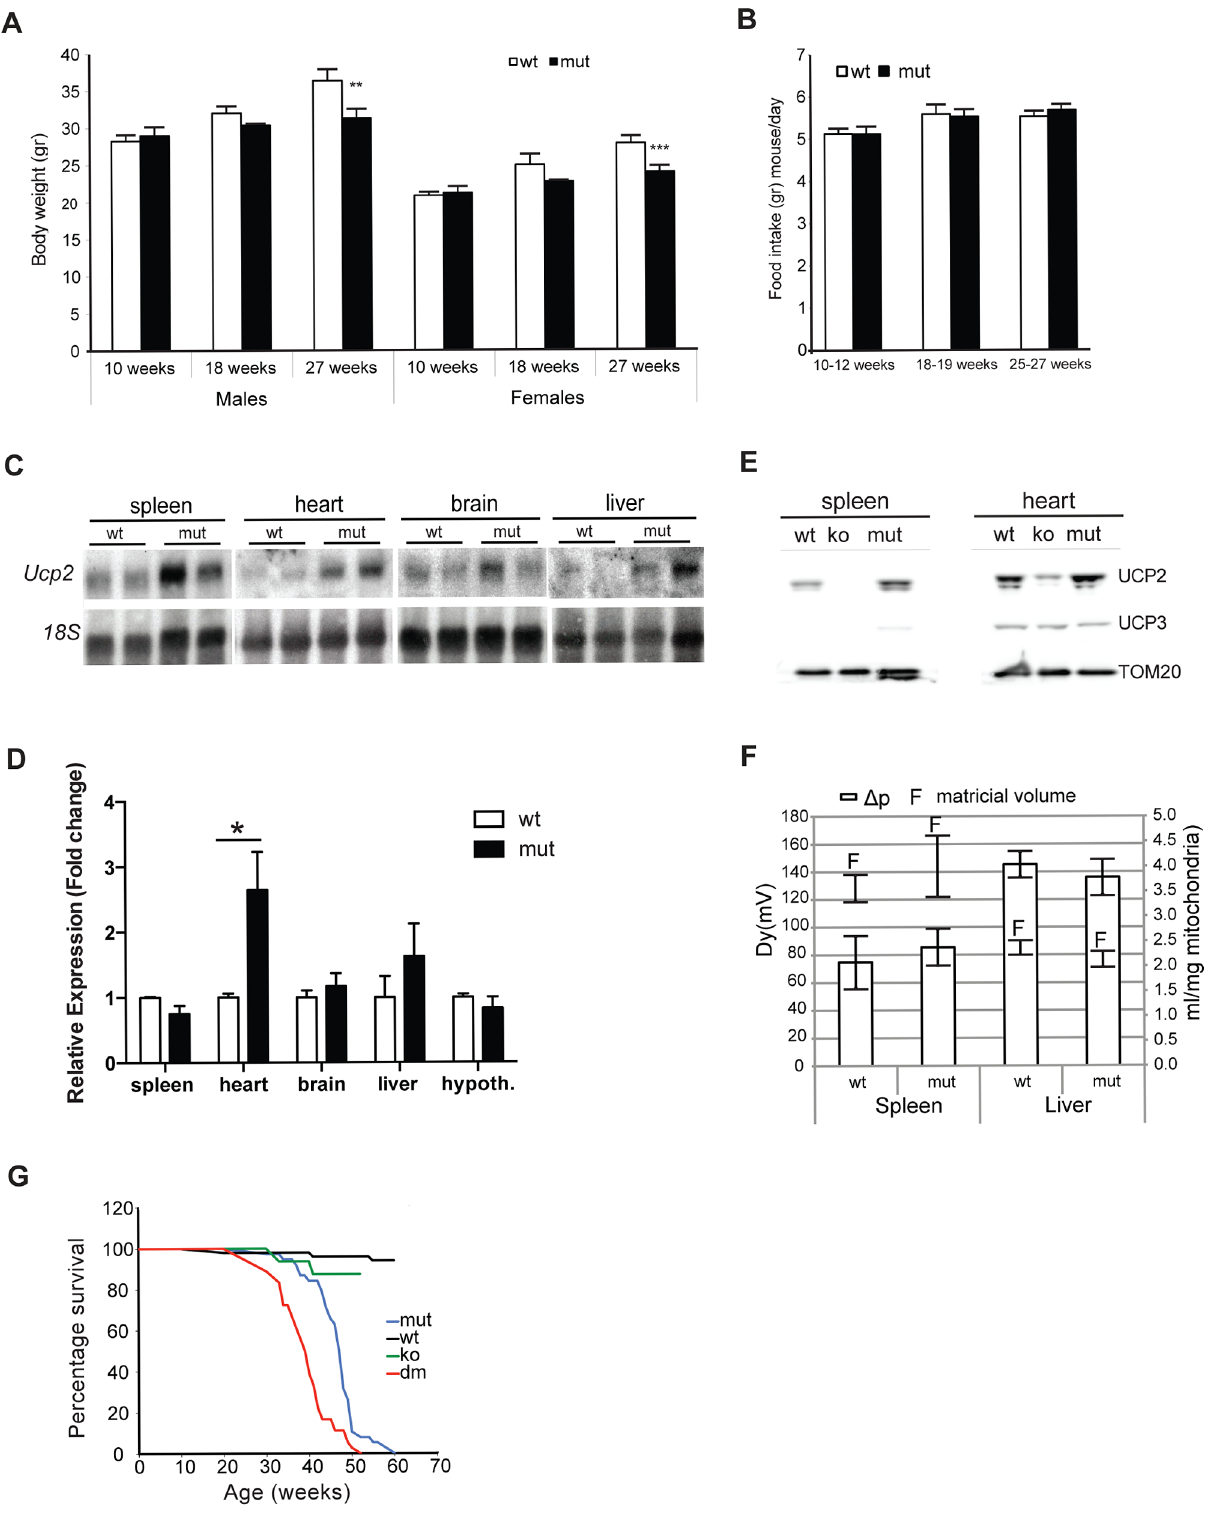
Figure 1. MtDNA mutator mice have lower body mass and upregulated UCP2 levels. Body weight (A) and daily food consumption (B) in mtDNA mutator (mut) mice in comparison to littermate controls (wt) (n=11). (C) Northern blot analyses of Ucp2 levels in spleen, heart, brain and liver. (D) Fold change of Ucp2 transcript levels in spleen, heart, brain, liver and hypothalamus for wt and mut (n=4). (E) Western blot analyses of UCP2 in spleen and heart mitochondria of wt, mut and UCP2-deficient (ko) mice. (F) Proton motive force (bars) and mitochondrial matrix volume (lines) in liver and spleen mitochondria (n=3). (G) Mean lifespan of wt, mut, ko and dm mice. All analyses were performed on 25-week-old mice. Bars indicate mean level 6 standard error of the mean (S.E.M.). Asterisks indicate level of statistical significance (*p , 0.05 **p , 0.01 ***p , 0.001, Student’s t